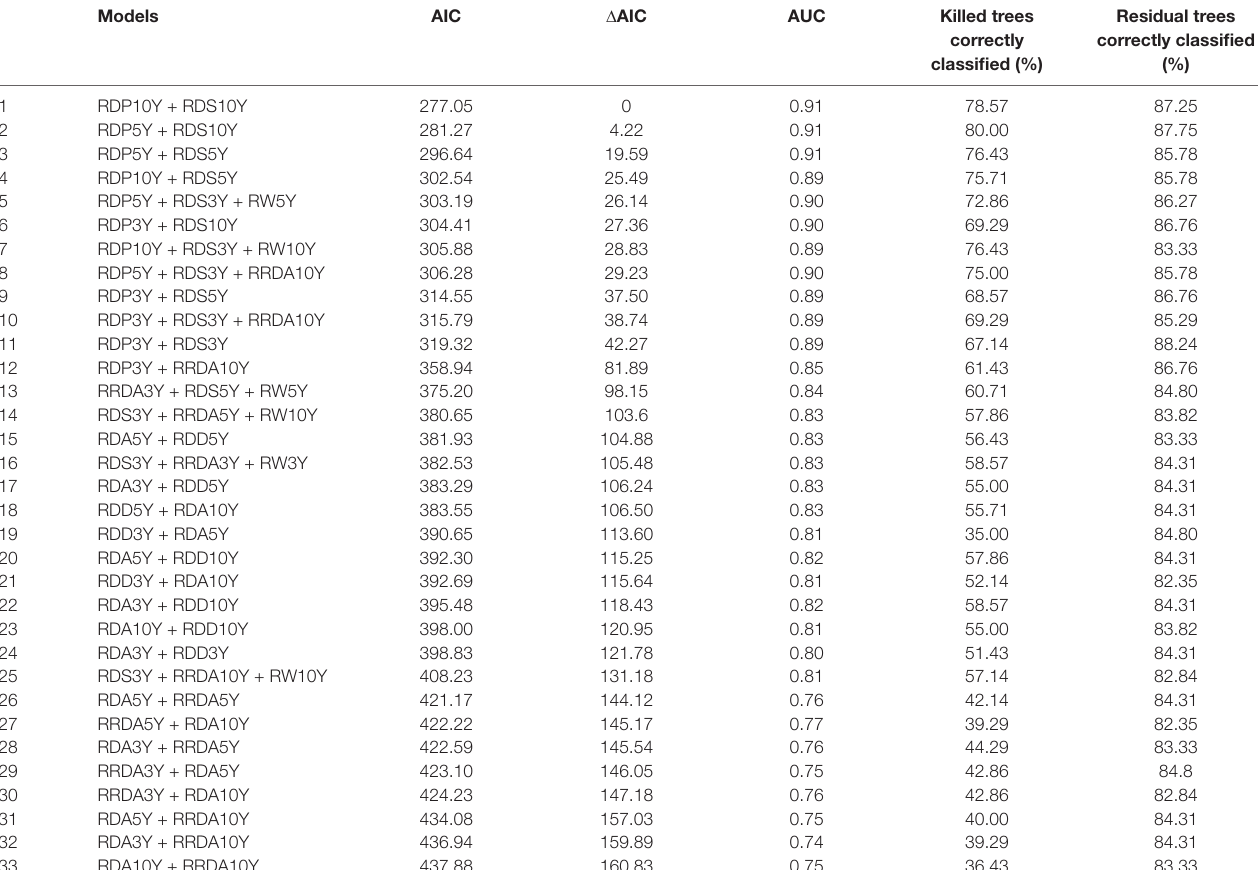
TABLe 2 | The models predicting the survival probability of Pinus contorta var. latifolia trees using Akaike’s Information Criterion (AIC) and delta AIC ( ∆ AIC), area under receiver operating curve (AUC), and internal validation results.